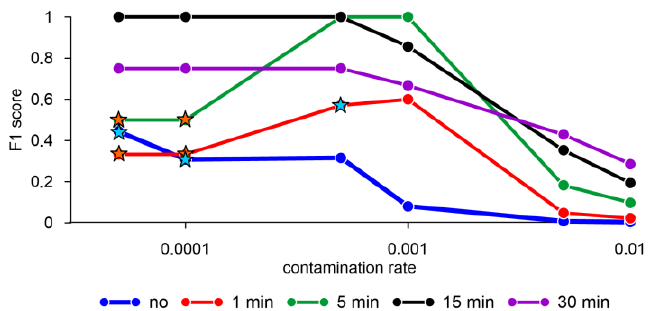
Figure 4. F1 score obtained by the elliptic envelope algorithm with different averaging of mollusk activity data and standardization of features. Orange stars — error FN=1, blue stars — error FN=2. Hereinafter the X scale is logarithmic.